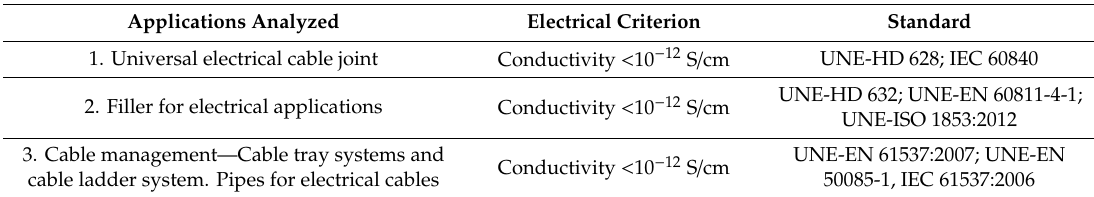
Table 4. Applications analyzed according to di ff erent standards, and the electrical criterion for them. Applications